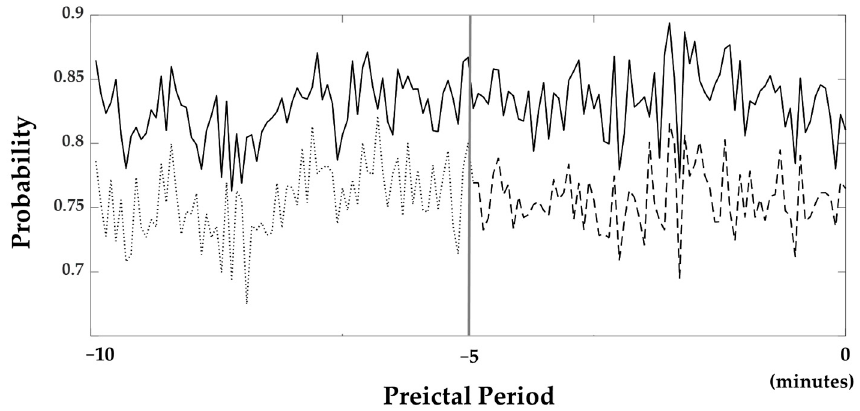
Figure 4. Probabilities resulted from the softmax layer. The bold line is the probability when the 10 min preictal period was used as the training set. The dashed line is the probability when the 5 min preictal period was used. Furthermore, the probability 5 to 10 min prior to seizure onset was also shown with the dotted line. The gray line located in the middle of the figure indicates 5 min prior to seizure onset.